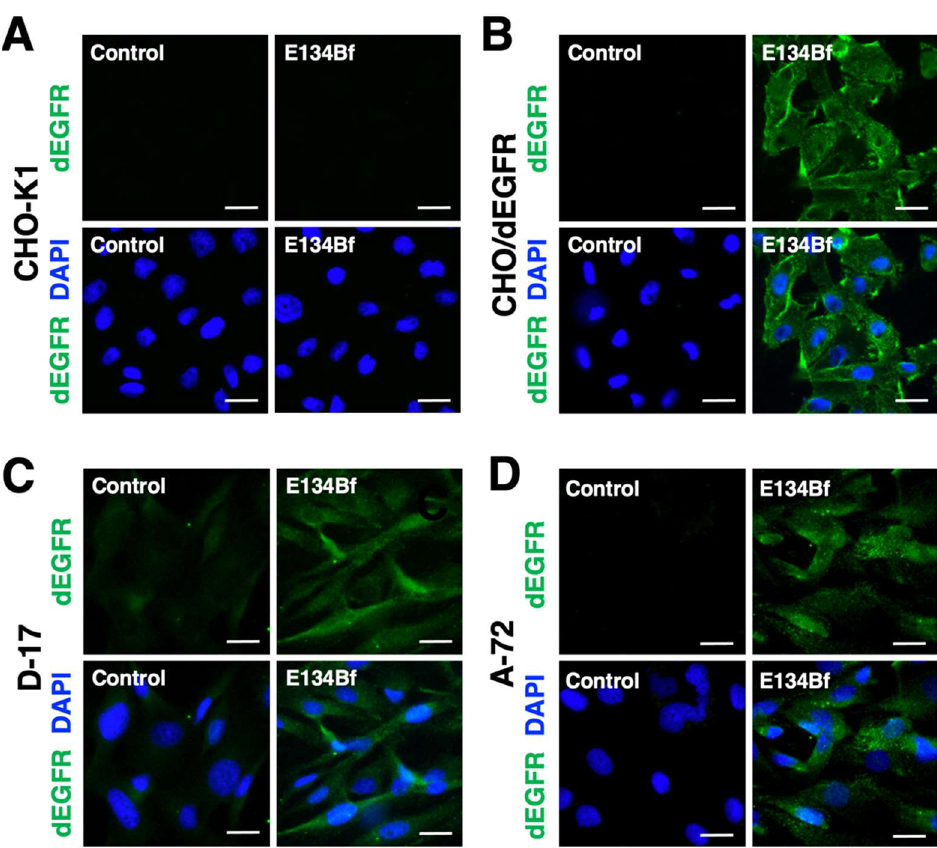
Figure 2. Flow cytometry using E134Bf. ( A ) CHO-K1, CHO/dEGFR, D-17, and A-72 cells were treated with E134Bf or buffer control, followed by FITC-conjugated anti-dog IgG. ( B ) Determination of the binding affinity of E134Bf for CHO- K1, CHO/dEGFR, D-17, and A-72 cells via flow cytometry. The cells were suspended in 100 μL of serially diluted E134Bf, followed by the addition of FITC-conjugated anti-dog IgG. Fluorescence data were collected using the EC800 Cell Ana- lyzer.